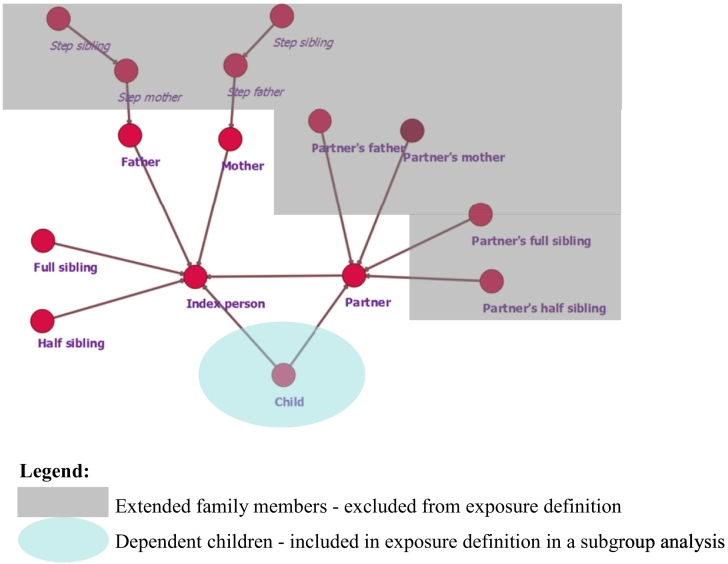
Family members included in family network exposures.Legend:Image 1 Extended family members - excluded from exposure definitionImage 2 Dependent children - included in exposure definition in a subgroup analysis.